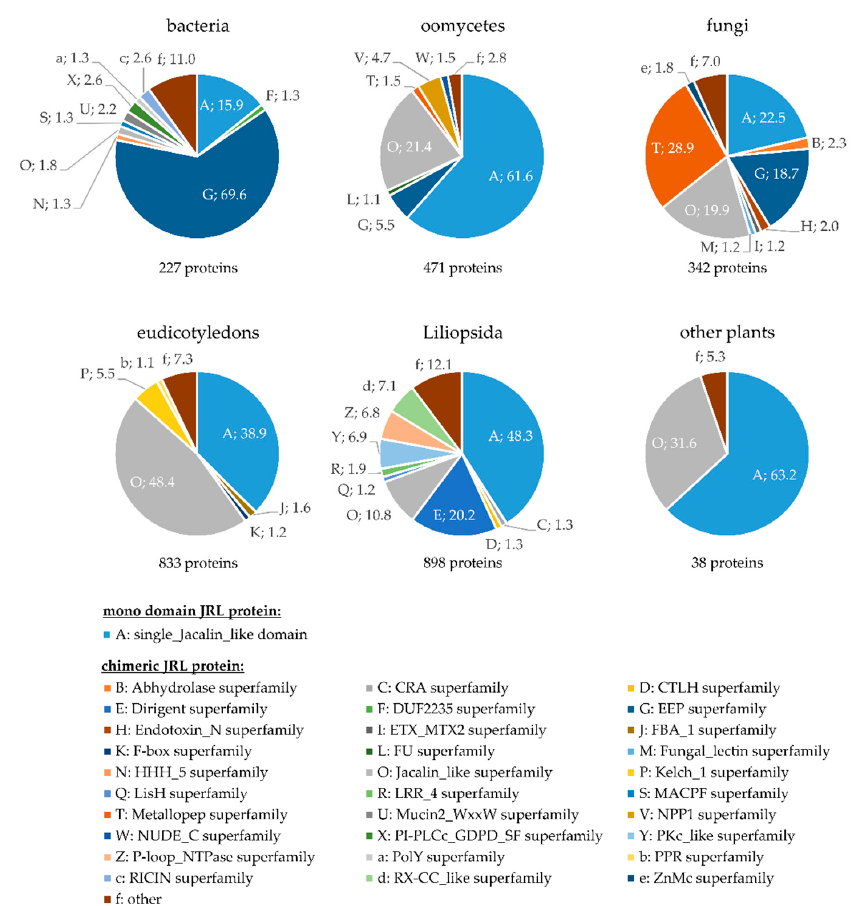
Figure 1. Proportional distribution of JRL domain containing proteins by superfamilies, among different kingdoms and taxa. JRL proteins (PF01419) of different taxonomic groups (bacteria, oomycetes, fungi, eudicotyledons, Liliopsida (monocotyledons) and other plants) were identified using UniProt. Domains were identified using NCBI Batch Web CD-Search Tool. Results were filtered for superfamilies as depicted. Below each pie chart the total number of JRL proteins that were found in the corresponding taxonomic group is given. Number next to the respective pie segment represent percentage of JRL domain containing proteins in depicted superfamily. Since chimeric JRL proteins may contain more than one partner domain, the respective protein might occur in different superfamilies, increasing the total percentage to >100. CRA: CT11-RanBPM; CTLH: C-terminal to